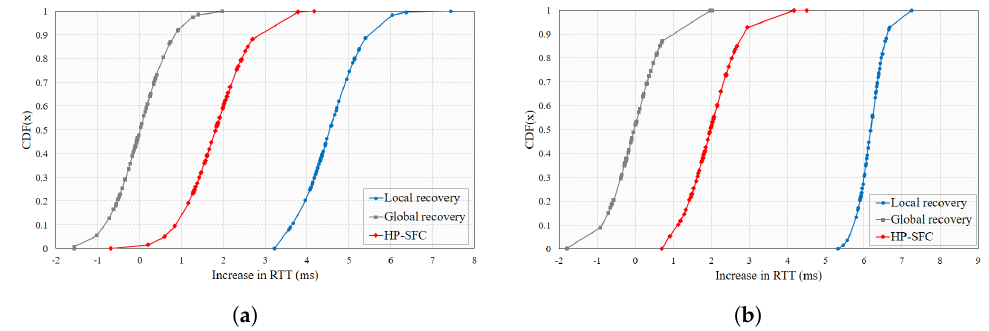
Figure 7. Data center topology, average RTT increment of SFCs 1, 2, and 9 for local recovery, global recovery, and HP-SFC protection mechanisms. ( a ) RTT increment for SFF-SFF link failure. ( b ) RTT increment for SF-SFF link